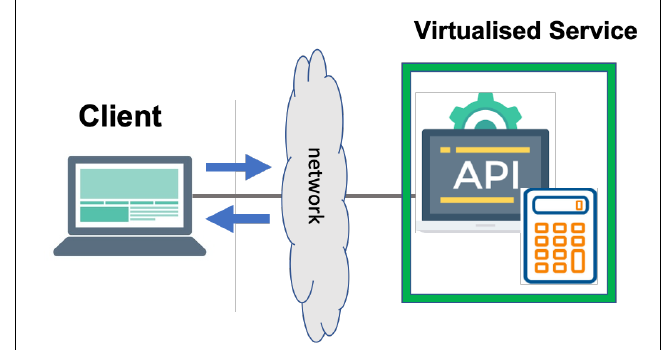
Figure 9. Calculator